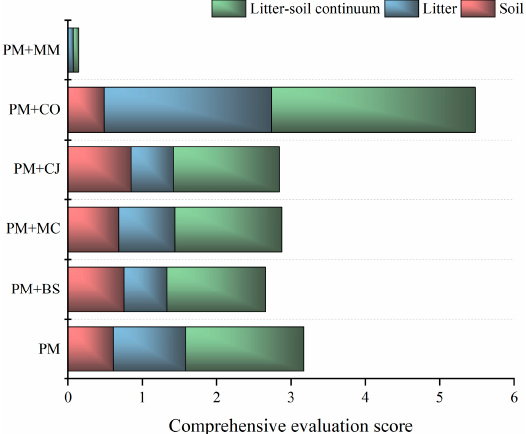
Figure 3. Comprehensive evaluation of water capacity function in the litter–soil continuum of different forest types. Note: the lower the comprehensive evaluation score, the higher the water conservation capacity in the litter–soil continuum. Pinus massoniana (PM), Bretschneidera sinensis (BS), Manglietia chingii (MC), Cercidiphyllum japonicum (CJ), Camellia oleifera (CO), and Michelia maudiae